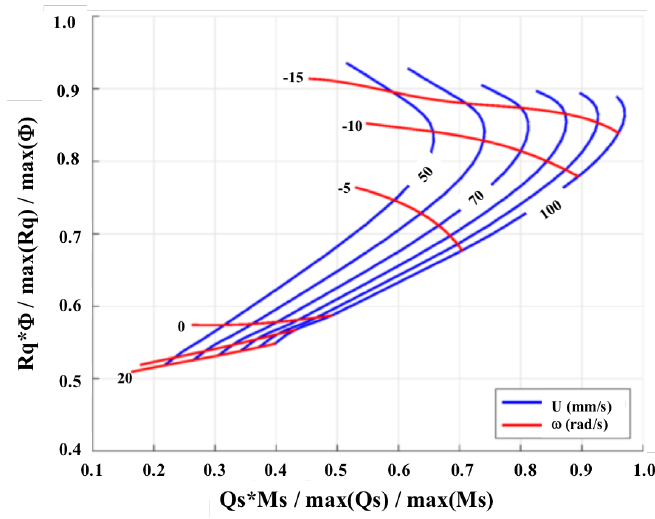
Figure 10. Spreading process map relating hybrid spread layer properties or spreadability metrics to the translation speed U and rotational speed ω of the spreader for polydispersed Ti-6Al-4V